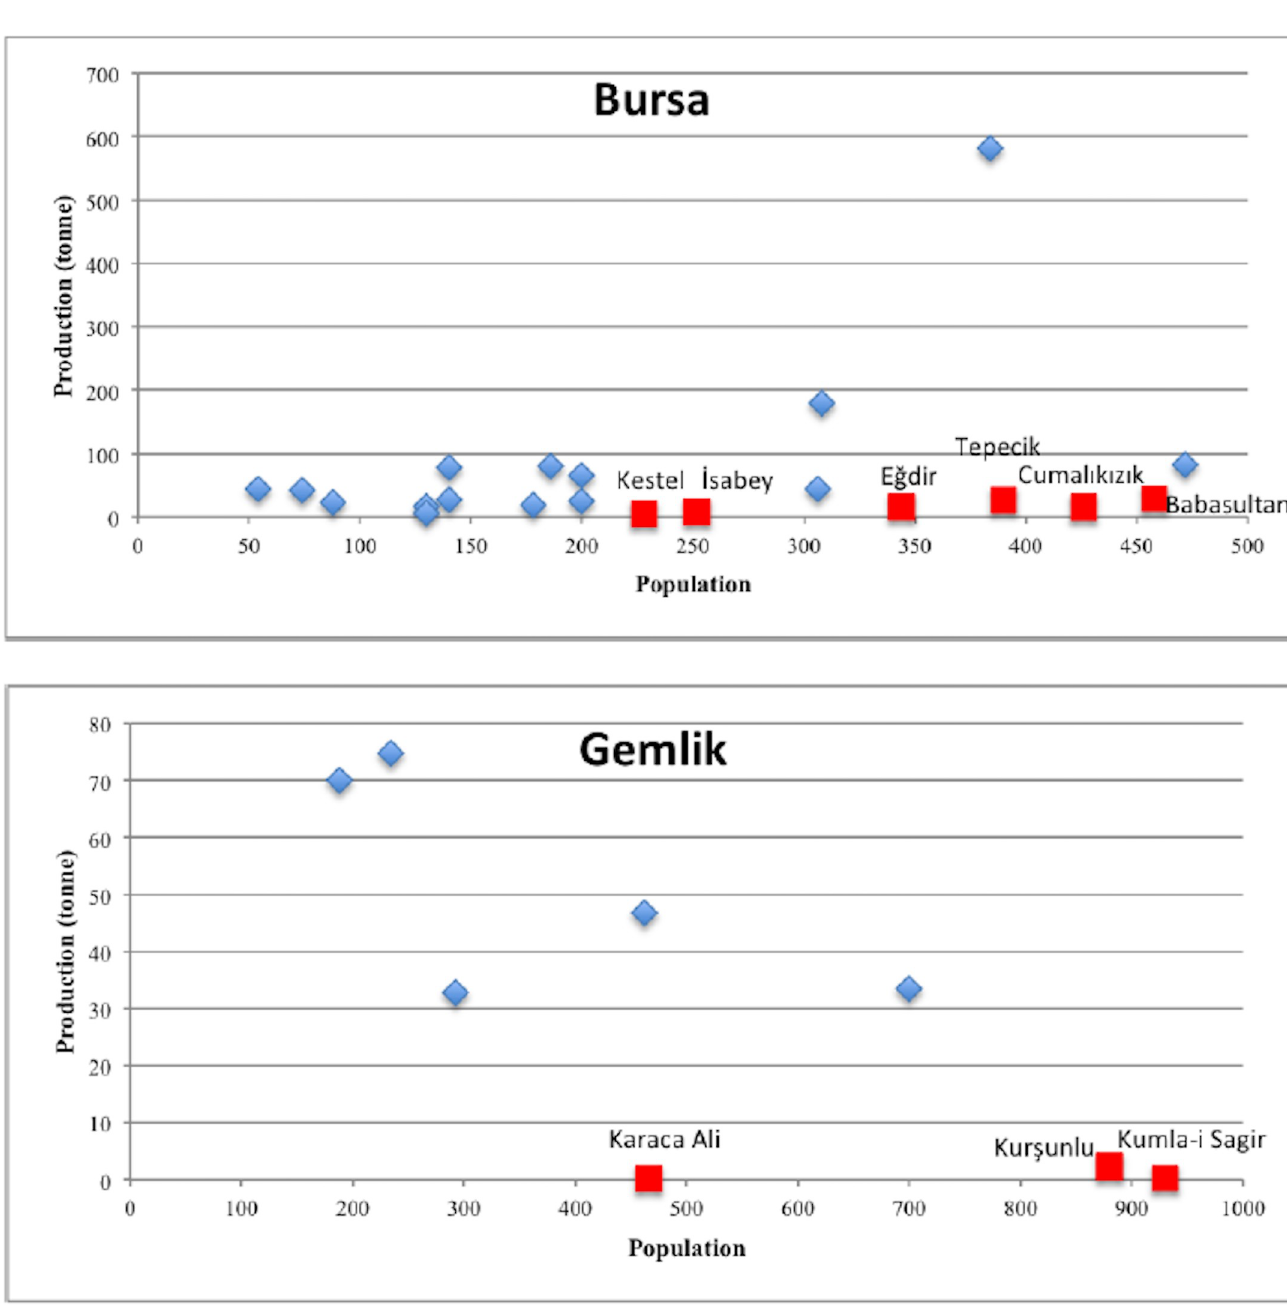
Fig 7. The observed relationship between population and agricultural production in Bursa and Gemlik. land area was searched for the selected regression model (Model 4). Its positive relationship with population confirms our expectation that there was a land expansion process associated with the population growth in the sub-districts of Bursa. Bursa Region’s selected settlements in Table 9. The information on the remaining settlements can be obtained from the authors on request.